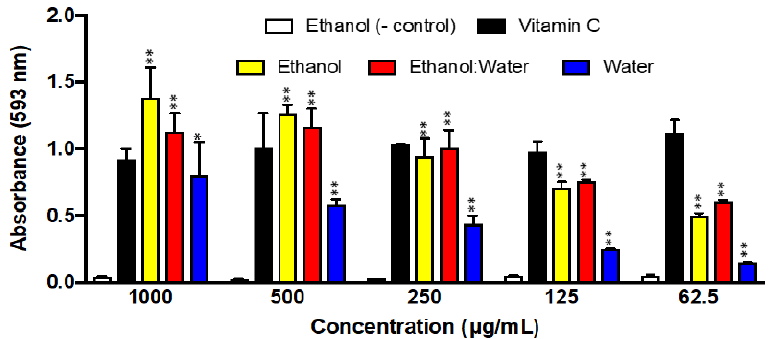
Figure 6. Iron Reducing Antioxidant Potential (FRAP) of three LT plant extracts at different concentrations (1000 µg/mL–62.5 µg/mL) after 5 min of incubation. The absorbance was recorded at 593 nm. Each bar represents the average of three replicates and the error bars represent the standard deviation. The asterisks indicate a significant difference between the treatment and negative control (* p < 0.05 and ** p < 0.001).